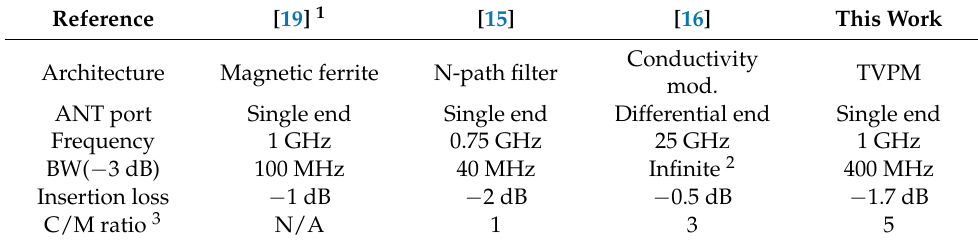
Table 2. Comparison between different methods to achieve the